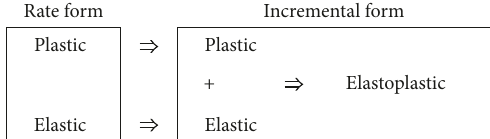
Figure 2: Incremental form of the elastoplastic bipotential deriving